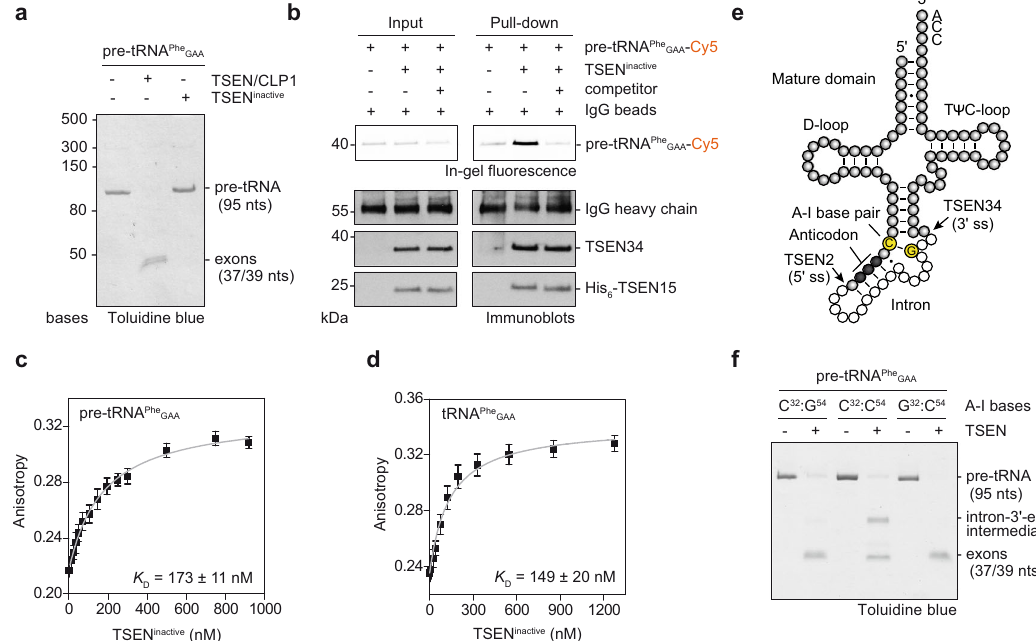
Fig. 2 Active involvement of the A – I base pair in coordinating pre-tRNA cleavage. a Pre-tRNA cleavage assay comparing recombinant, inactive TSEN tetramer (TSEN2 H377A and TSEN34 H255A double mutant) to the TSEN/CLP1 complex. Cleavage products are visualized by denaturing urea-PAGE with subsequent Toluidine blue staining. RNA size markers are indicated on the left of the gel. b Pull-down assay with fl uorescently labeled S.c . pre-tRNA Phe GAA and inactive, tetrameric TSEN captured on protein G agarose functionalized with an α -His-antibody. Protein size markers are indicated on the left of each immunoblot, protein and RNA identities on the right. Input and co-precipitated, labeled pre-tRNAs were visualized by in-gel fl uorescence, TSEN subunits, and the immunoglobulin G (IgG) heavy chain by immunoblotting. The IgG heavy chain served as a loading control. c Thermodynamic binding parameters of fl uorescently labeled S.c . pre-tRNA Phe fl uorescence anisotropy. d Thermodynamic binding parameters of GAA and inactive, tetrameric TSEN revealed by fl uorescently labeled tRNA Phe fl uorescence anisotropy. Data in c and d are presented as mean values ± SD. GAA and inactive, tetrameric TSEN revealed by e Schematic depiction of a pre-tRNA molecule showing ribonucleotides belonging to the mature domain (gray spheres), the intronic region (white spheres), the anticodon (black spheres), and the A – I base pair (yellow spheres). Proposed 5 ′ and 3 ′ splice sites (ss) are indicated. f Impact of A – I base pair mutations in S.c . pre-tRNA Phe GAA on the endonucleolytic activity of tetrameric TSEN revealed by a pre-tRNA cleavage assay. C 32 :G 54 – canonical A – I base pair, C 32 :C 54 – disrupted A – I base pair, G 32 :C 54 – inverted A – I base pair. All experiments are representatives of three independent assays. Source data for a , b , and f , are provided as Source Data fi